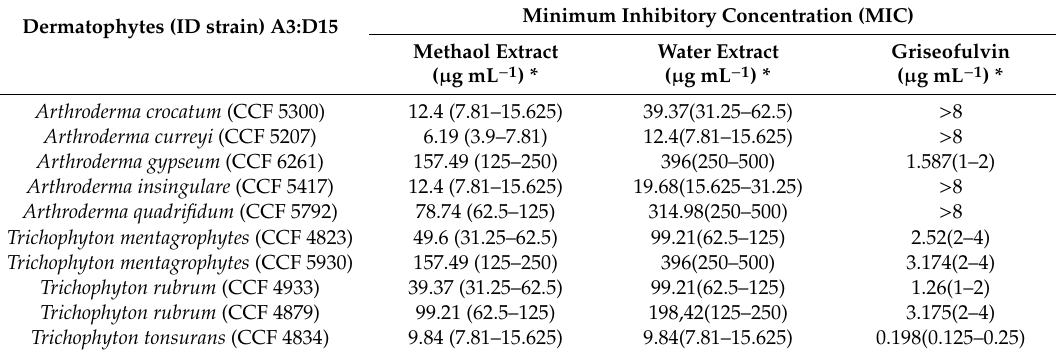
Table 6. Minimal inhibitory concentrations (MICs) of P foetida methanol and water extracts, and griseofulvin towards selected